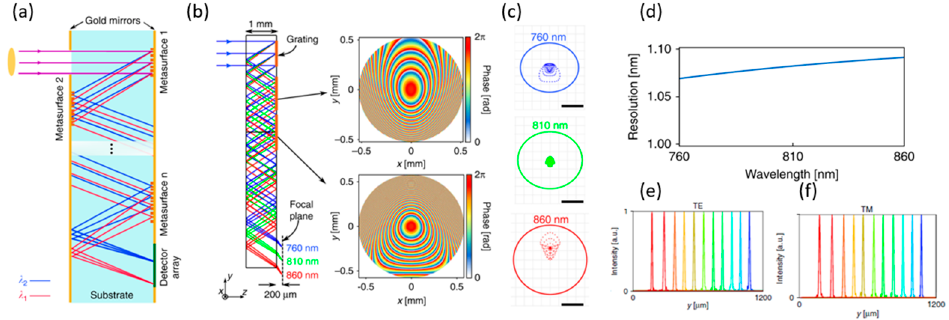
Figure 17. Compact aberration-corrected spectrometer characterizations. ( a ) Schematic of a doublet, comprising of a metasurface corrector and the original aberration-corrected off-axis metalens. The corrector serves to impart group delay (GD) and group delay dispersions (GDDs) such that the focal spot positions of the metalens are linear in frequency. ( b ) Plots of the focal spot positions of the singlet metalens ( blue ) and the doublet ( orange ) as a function of frequency. ( c ) Plot of the required phase as a function of frequency for an element at the edge of the metasurface corrector ( blue line ), and the results of second- and third-order polynomial fits ( orange crosses and black circles , respectively). ( d ) GD and GDD values required for elements across the middle of the metasurface corrector, along x and y directions ( blue circles and orange crosses ). Inset: magnified view of the dispersion required for elements along y , which is minimal, due to the choice of the orthogonal camera plane. (Reproduced from [107] with permission.)